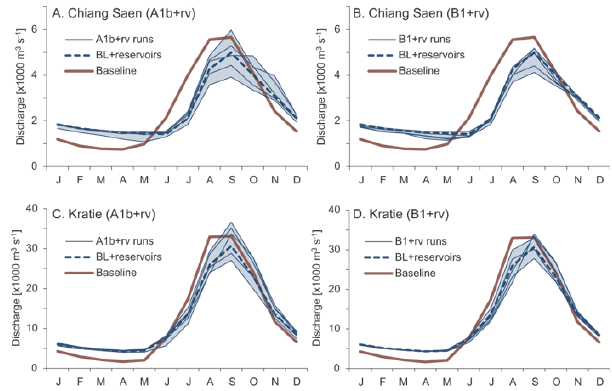
Fig. 6. Cumulative impacts of climate change and reservoir opera- tions on Mekong main river discharge. Monthly average discharges of the model runs under emission scenarios (2032–2042) compared to baseline (1982–1992). (A) Chiang Saen using A1b emission sce- nario and reservoirs; (B) Chiang Saen using B1 emission scenario and reservoirs; (C) Kratie using A1b emission scenario and reser- voirs; and (D) Kratie using B1 emission scenario and reservoirs. See Tables S4 and S5 in the Supplement for tabulated data. Note the differing discharge